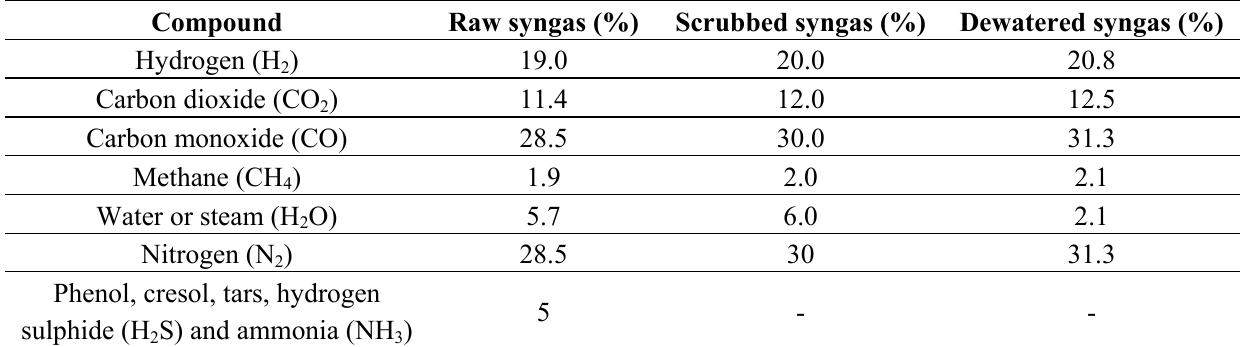
Table 1. Compounds of syngas at different stages of